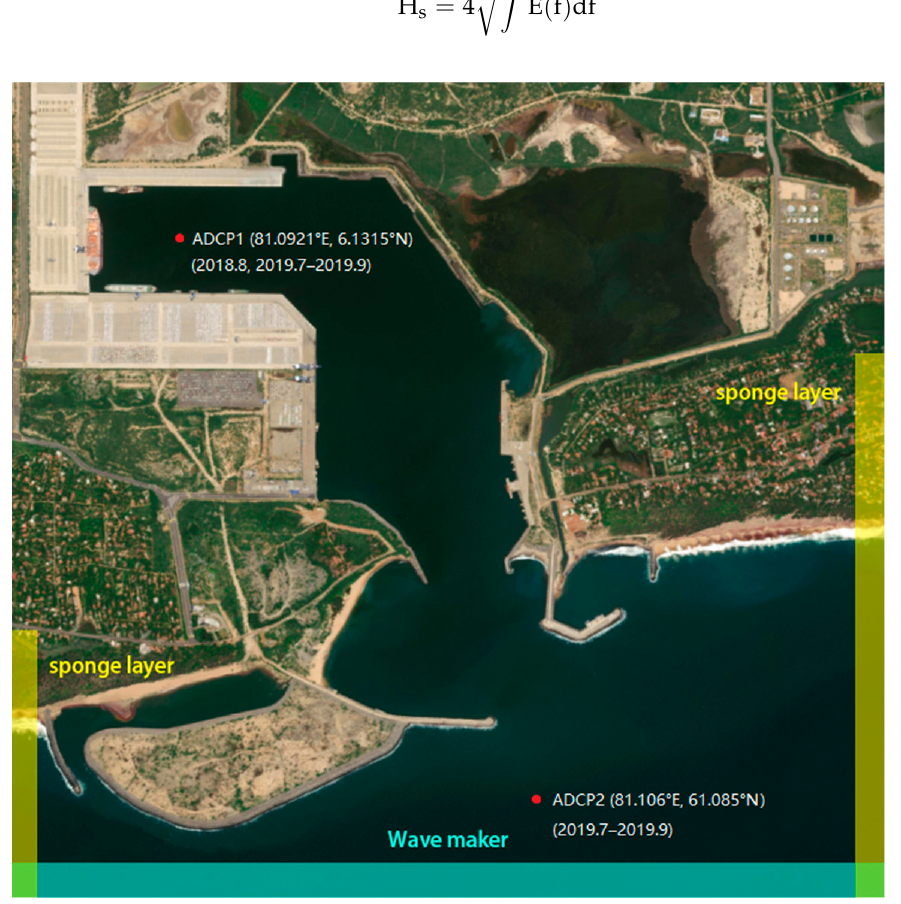
Figure 1. Setting of the wave maker and sponge layers. As shown in Figure 2, we made comparisons of the data generated by the calibrated SWASH model at the ADCP1 location at each hour of the buoy observation (the horizontal axis) and the buoy-observed data of each hour (the vertical axis) including SWH and PP1D, and they are roughly consistent. MAE is the mean absolute error, RMSE is the root mean square error, and PCC is the Pearson correlation coefficient. We did not compare wave direction because ADCP1 is located in the inner port, where waves experience diffraction and reflection many times, leading to complex composition and rapid changes in the mean wave direction (MWD), so comparison with buoy-observed MWD would be unhelpful. Therefore, the calibrated SWASH model can be used for in-port SWH dataset generation. In order to generate the in-port SWH dataset using the calibrated SWASH model, a variety of port-entrance wave parameters (SWH, PP1D, MWD, and WDW) were uniformly sampled from the ERA5 dataset in the time period of 2010–2020 at the entrance of the Hambantota Port as the inputs of the calibrated SWASH model for in-port SWH dataset generation. To validate the usability of ERA5 dataset at the port entrance, we compared the ADCP2-observed SWH and the SWH of ERA5 at the ADCP2 location interpolated by cubic spline interpolation, and the comparison result is shown in Figure 3. Finally, a total of 384 samples were obtained, as shown in Table